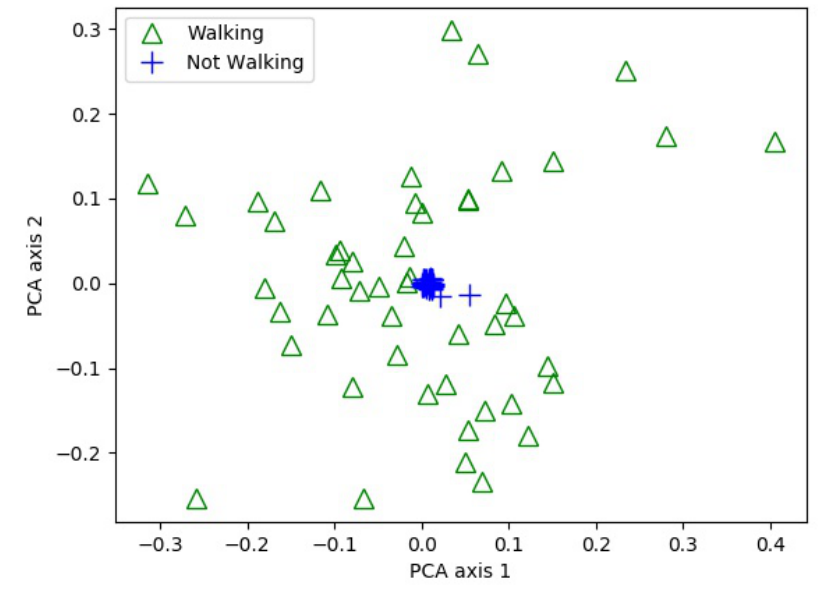
Figure 5. Principal component analysis of features used for motion